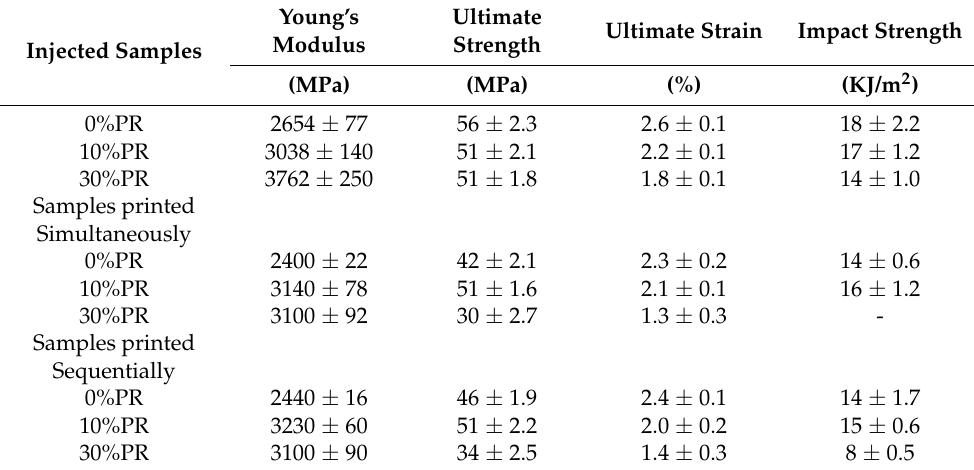
Table 7. Mechanical characterization results: Young’s modulus, ultimate strength, ultimate strain, and impact